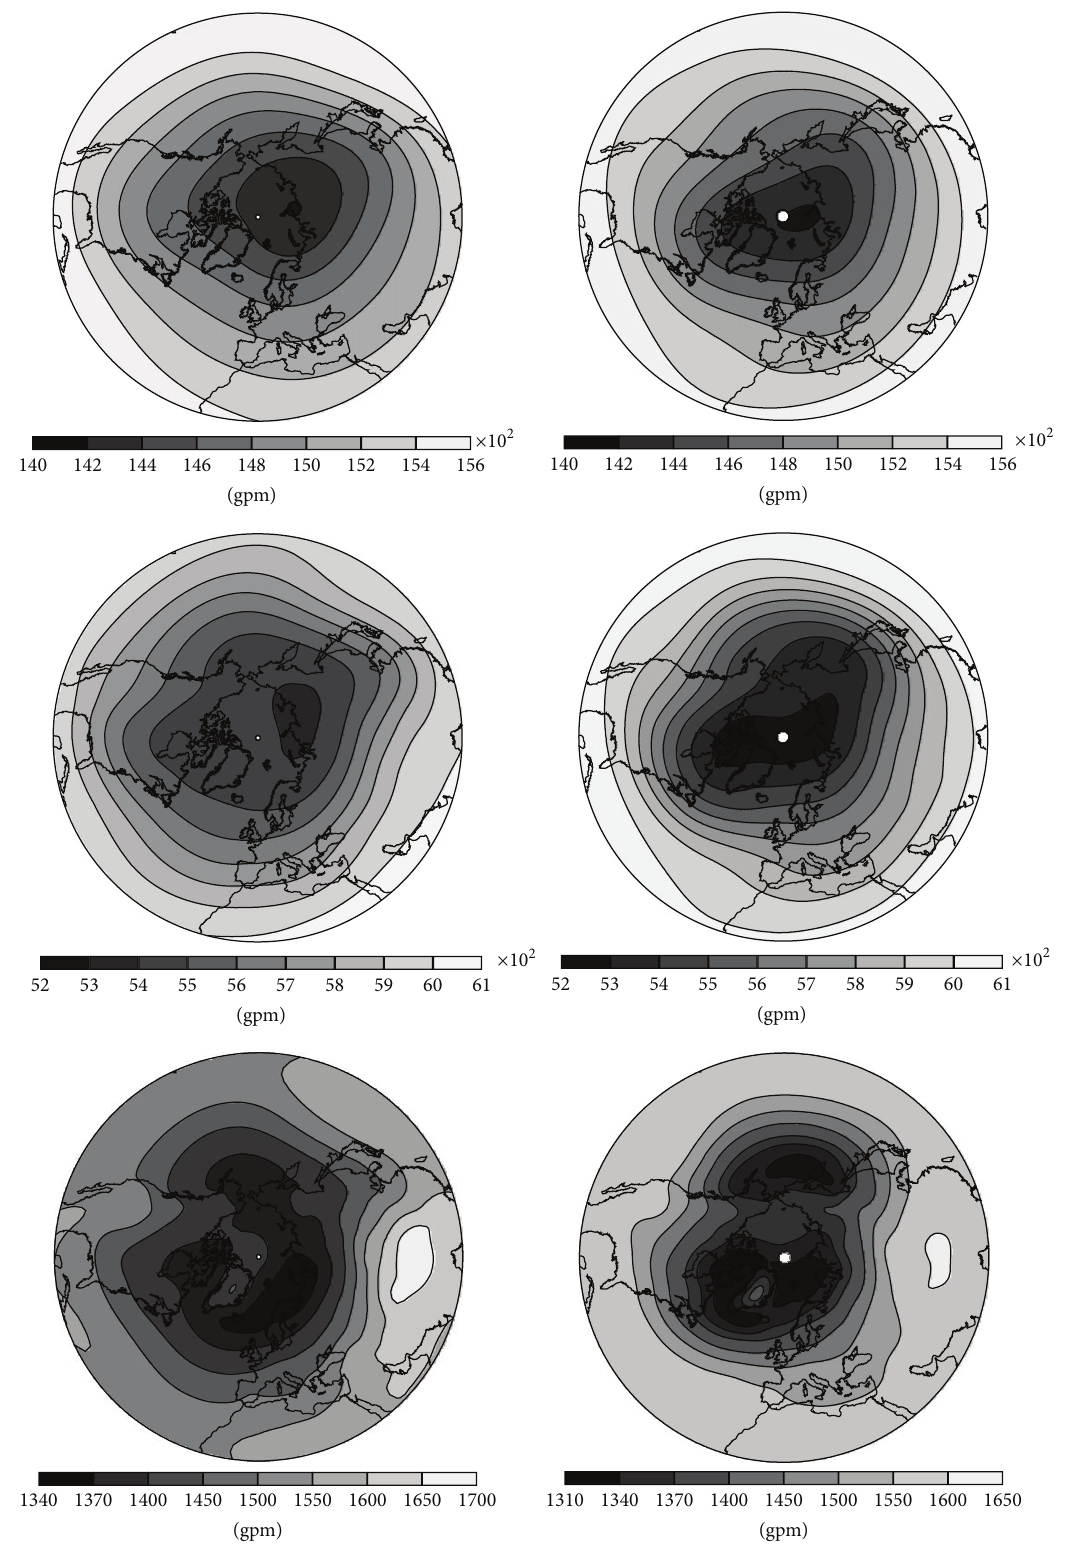
Figure 4: (Left) mean geopotential height (gpm) of the (top) 167hPa, (middle) 500 hPa, and (bottom) 833 hPa model level. (Right) same as left column, but for the layer-averaged NCEP-NCAR reanalysis